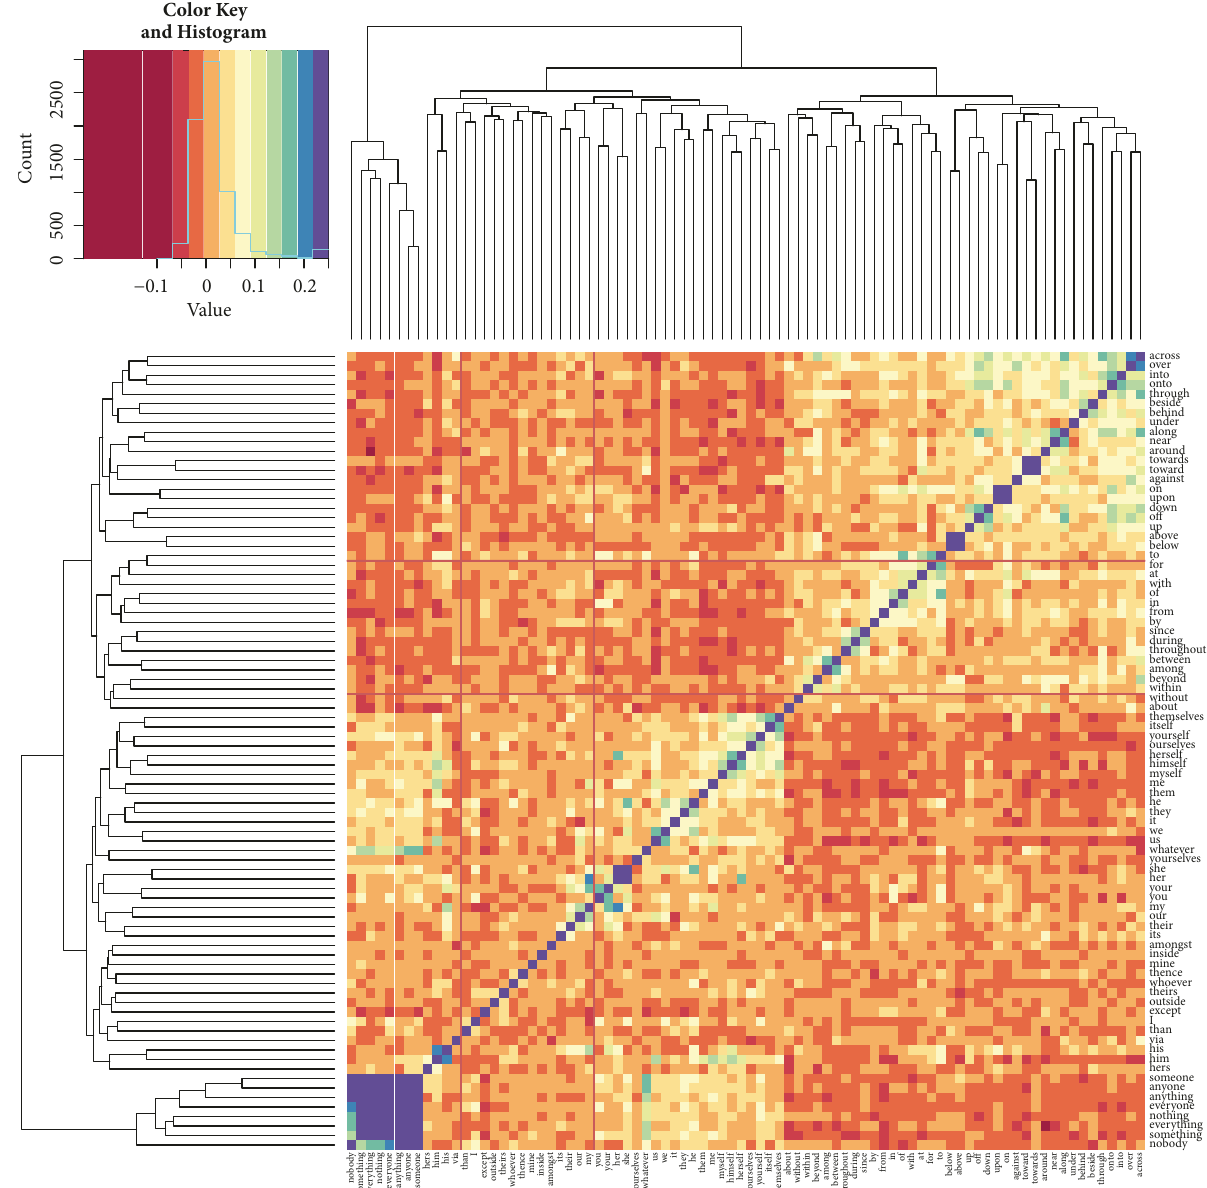
Figure 14: Heatmap for the correlations of the semantic vectors of pronouns and prepositions. Note that quantifier pronouns form a group of their own that prepositions and the other pronouns form distinguisable groups and that, within groups, further subclusters are visible, e.g., for we and us , she and her , and across and over . All diagonal elements represent correlations equal to 1 (this is not brought out by the heatmap, which color-codes diagonal elements with the color for the highest correlation of the range we specified,